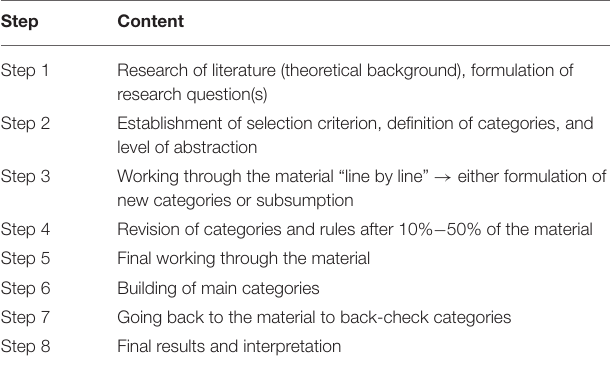
TABLE 3 | Summary description of Inductive Category Formation (Qualitative Content Analysis)